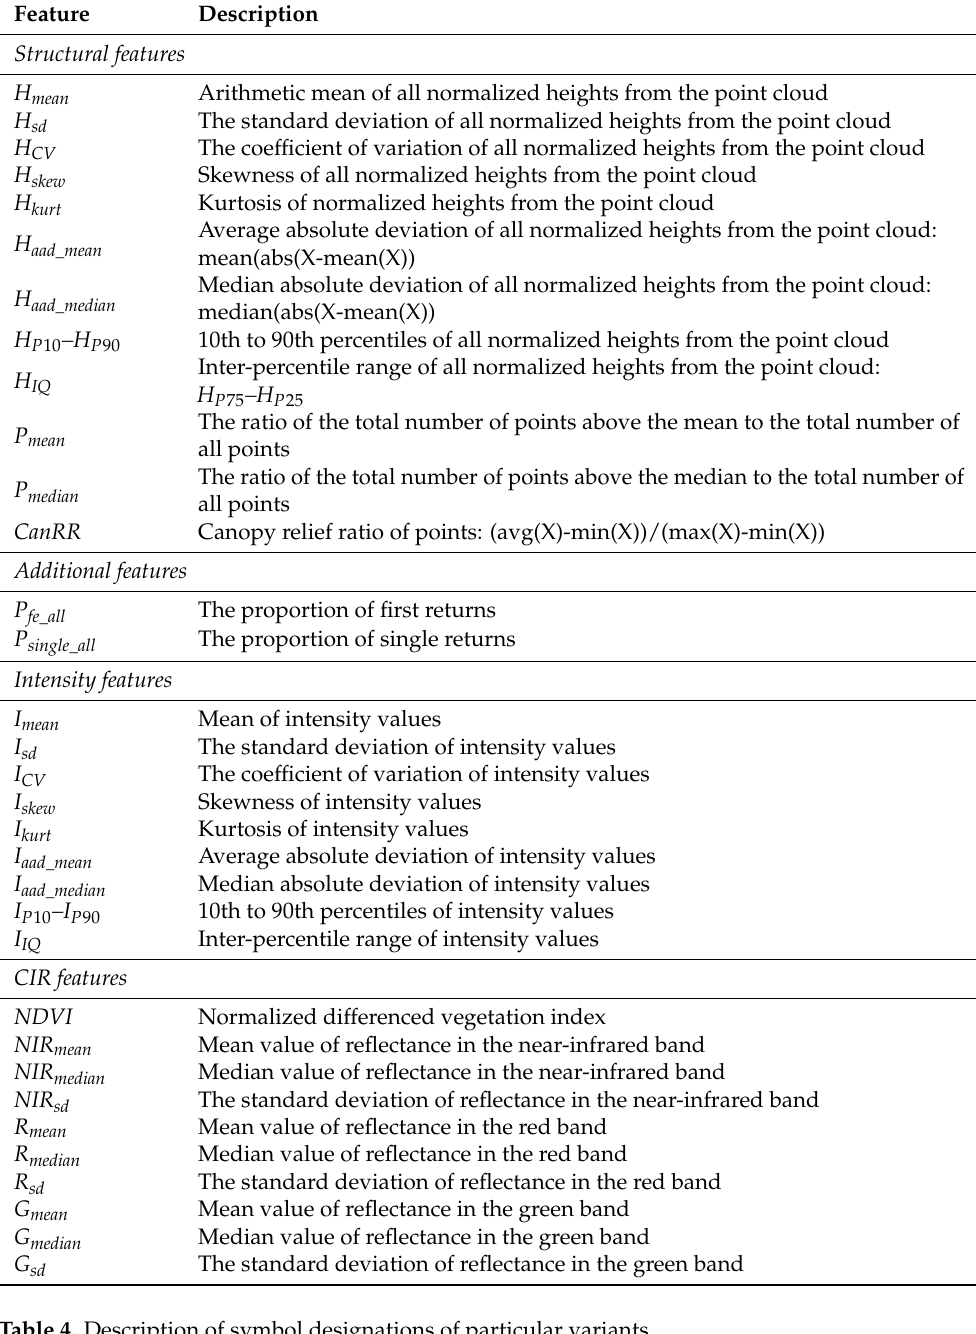
Table 3. Tree features derived from ALS data and spectral information.